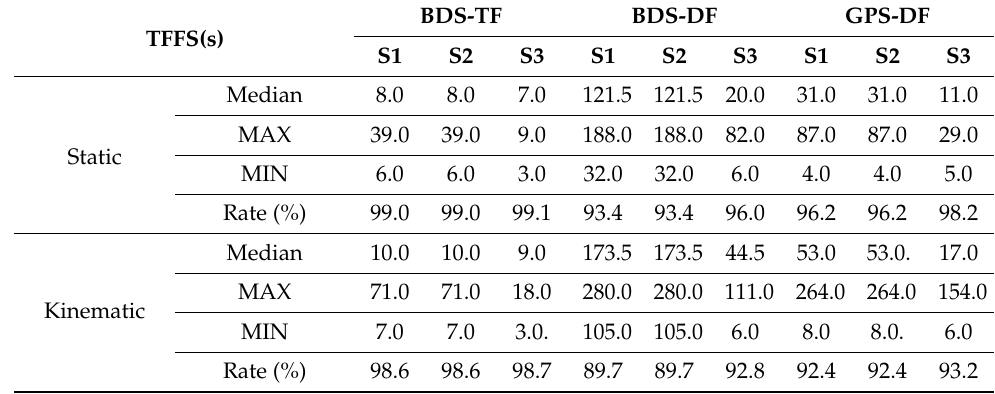
Table 4. Statistics of ambiguity fixing performance of Baseline C1, Sampling rate 1 s.